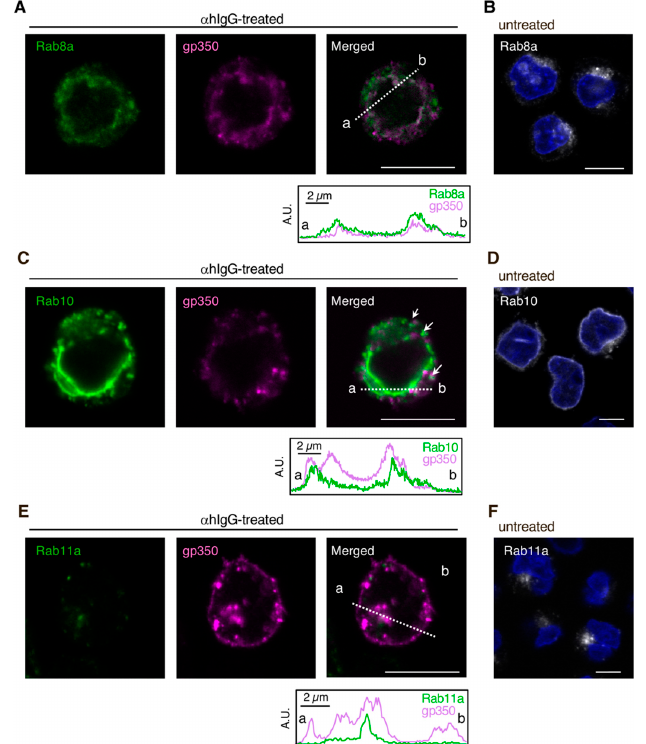
Figure 1. Epstein-Barr virus ( EBV) glycoprotein localized in the compartments containing the markers of the secretory pathway. The distribution of EBV glycoproteins and Rab8a ( A ), Rab10 ( C ) or Rab11a ( E ) in Akata + cells undergoing the lytic cycle. Akata + cells were treated with or without α hIgG for 48 h. The distribution of Rab proteins (green), gp350/220 (magenta), and merged images are shown. As a control, the distribution of Rabs (white) in the untreated cells is shown (B, D , F ). The nuclei (blue) were counterstained with Hoechst 33342. The plots indicate the individual fluorescence intensity along each of the corresponding lines. A.U., arbitrary unit. Scale bars: 10 µm. Looking at Rab8a, a small GTPase that regulates secretory vesicle transport from the TGN to the basolateral PM of epithelial cells, neuronal dendrites, and cilia [46,47], was, as expected in basal conditions (non-induced cells), distributed in the perinuclear region and in the cytoplasm, forming vesicle-like structures (white; Figure 1B). The localization of Rab8a was maintained in cells induced for the EBV lytic cycle (green; Figure 1A) and partially co-localized with gp350/220 staining (magenta; Figure 1A). These observations were overall similar for Rab10, a transport mediator of glucose transporters as well as toll-like receptor 4, to the PM [46,47]. Rab10 also showed perinuclear localization in a more intense fashion, together with a cytosolic distribution associated with vesicle- like structures, both in basal (white; Figure 1D) and induced states (green; Figure 1C). Additionally, in line with the result obtained for Rab8a, gp350/220 partially co-localized with Rab10, both in the perinuclear region and in the cytosol: some gp350/220-positive speckles were frequently seen adjacent to Rab10 signals (Figure 1C; white arrows). On the other hand, Rab11a, a GTPase indispensable for both regulated secretory pathways and constitutive recycling processes [48–50], was detected in the perinuclear regions of untreated cells (white; Figure 1F), however, its localization